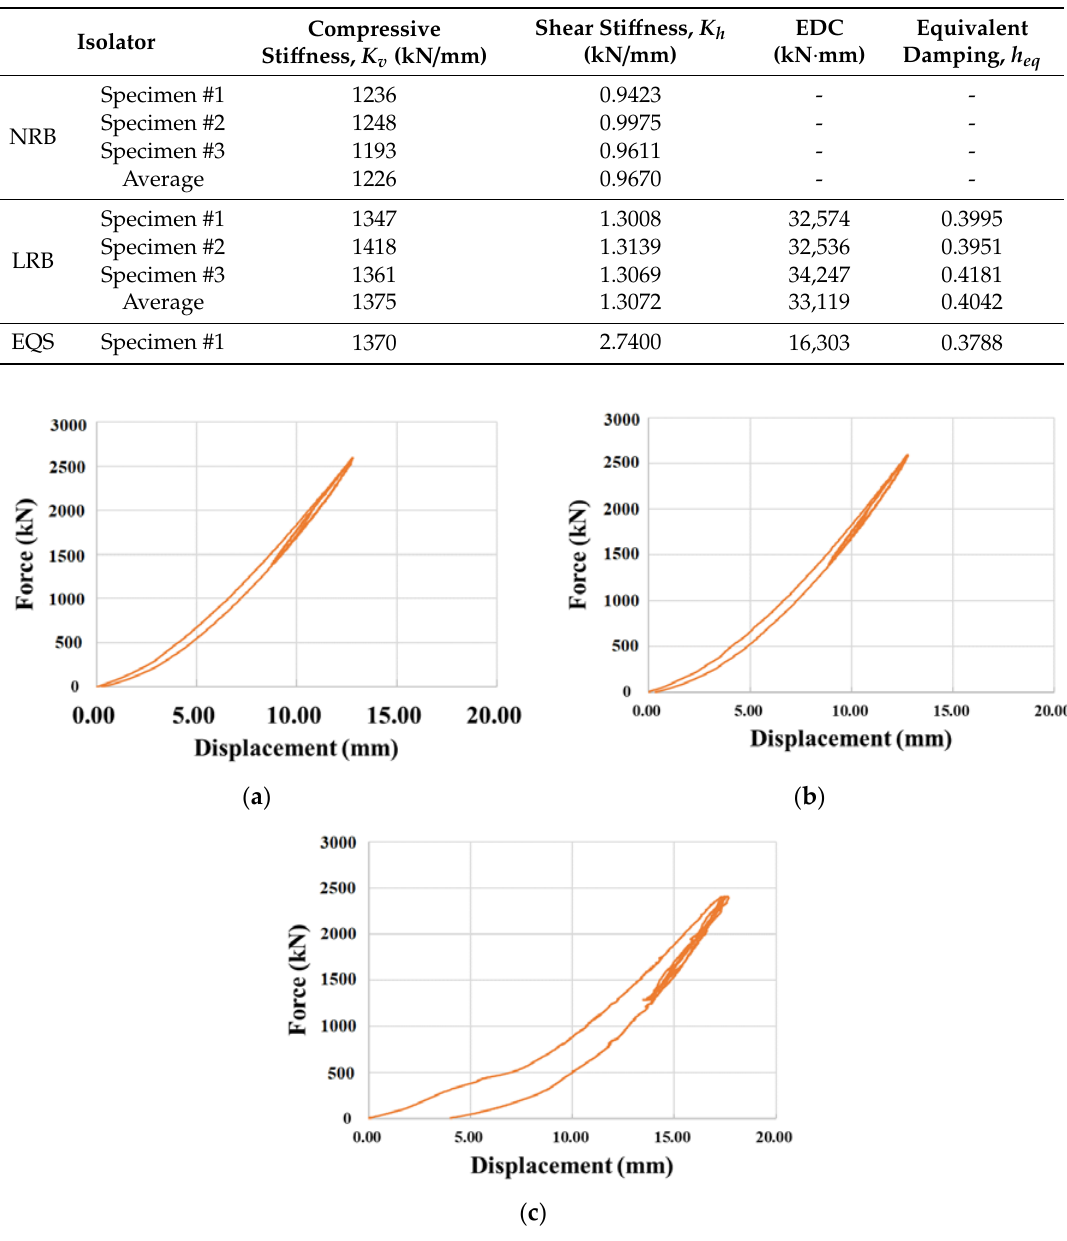
Table 4. Compressive test results of NRB, LRB, and EQS specimens.